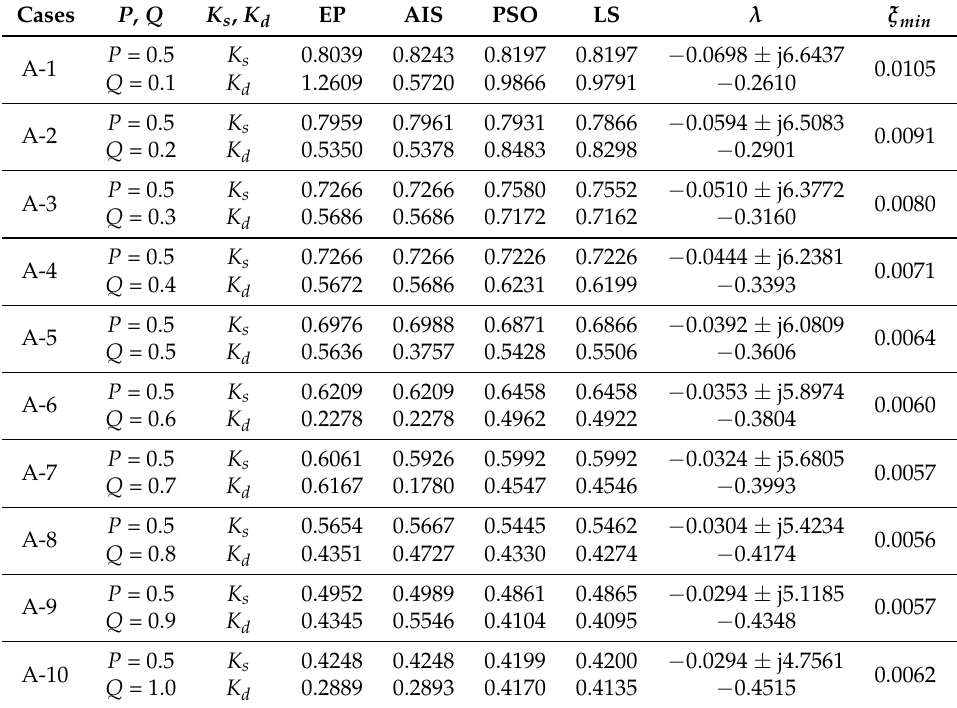
Table 3. K s and K d via EP, AIS, PSO, LS, eigenvalues and ξ min for Event